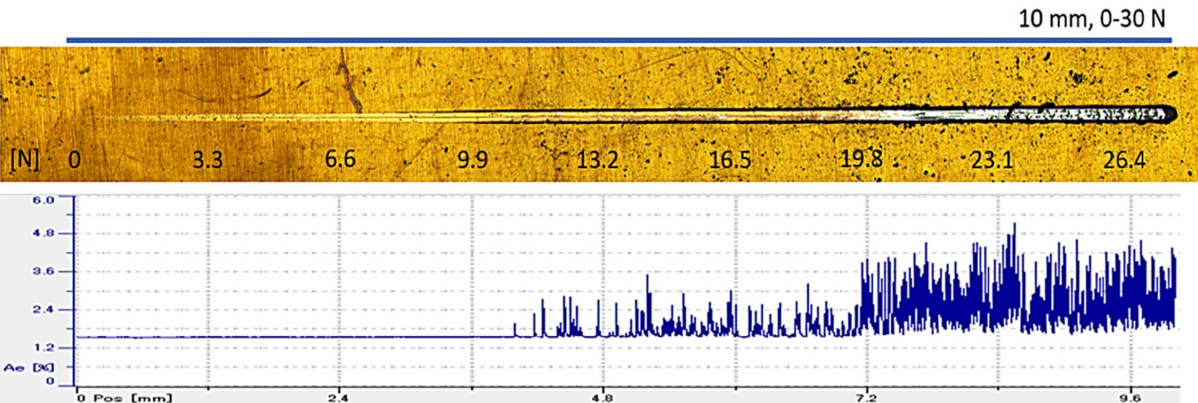
Figure 8. Optical microscope images of the indentation carried out on the coating’s surface.